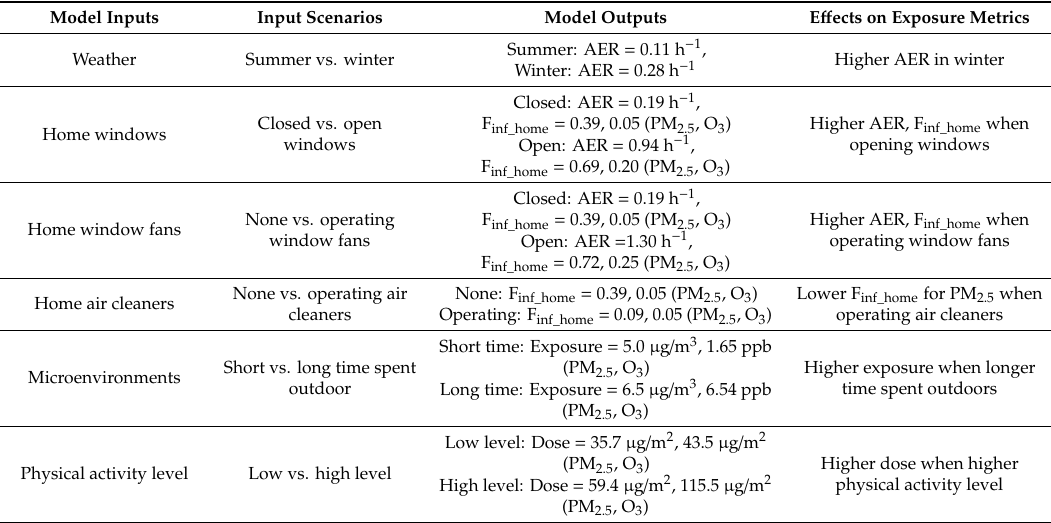
Table 6. Sensitivity analysis of TracMyAir outputs for six di ff erent input